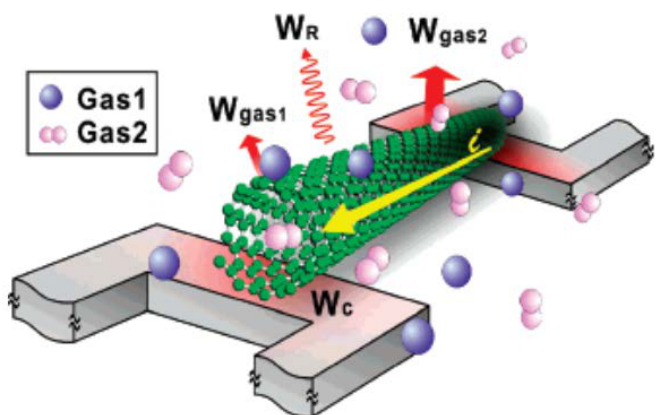
Figure 10. Schematic diagram displaying the architecture and gas-sensing mechanism of suspended CNT, “Reprinted/adapted with permission from Ref. [103]. 2007, Kawano, T. et al.”.